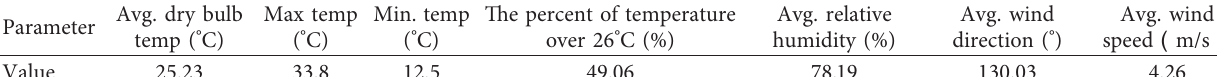
Table 3: Climate information of Dongfang.